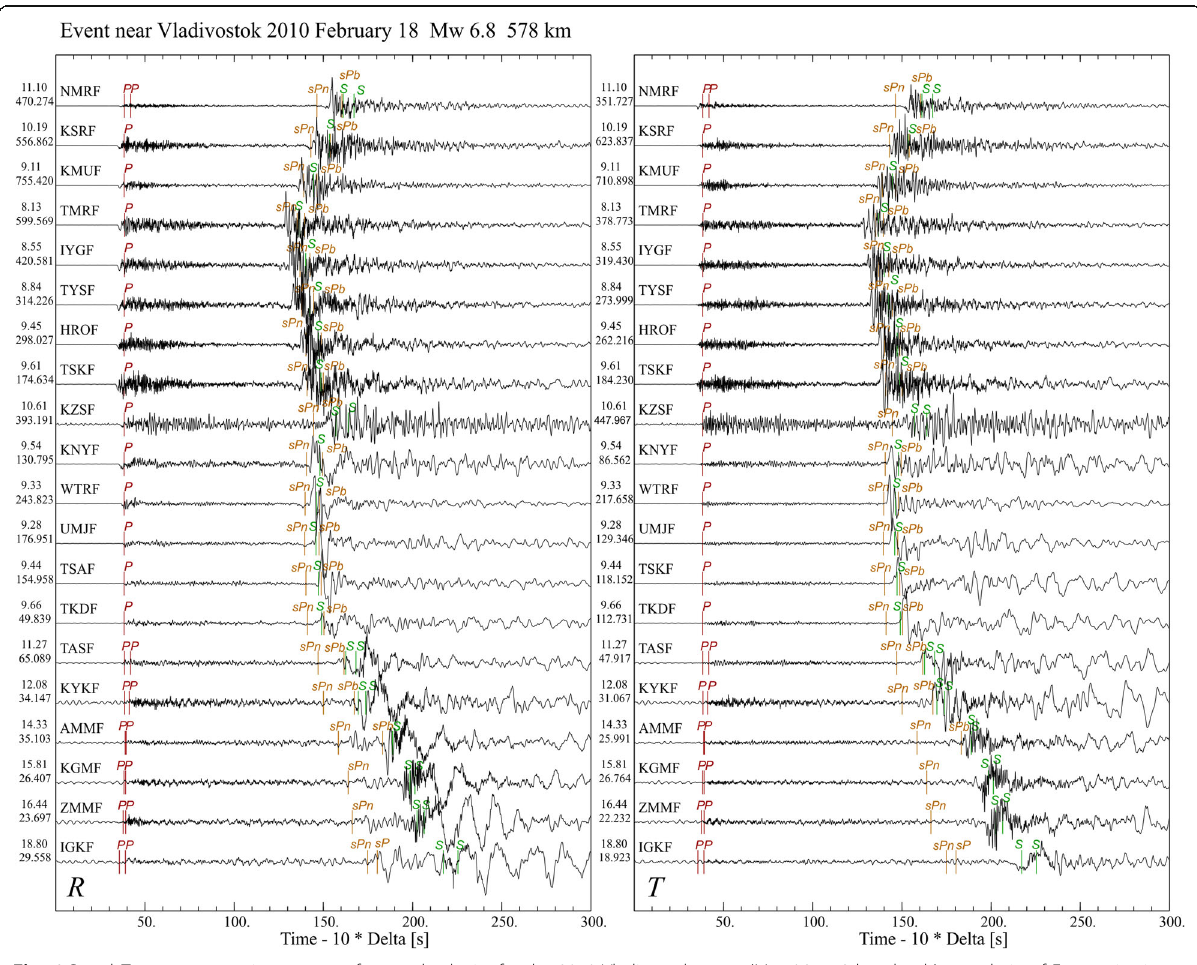
Fig. 6 R and T component seismograms of ground velocity for the 2010 Vladivostok event (Mw 6.8, 578 km depth) at a chain of F-net seismic stations along the Japanese islands, shown with solid symbols in Fig. 5. For each station, the epicentral distance is indicated in degrees, with the maximum amplitude in μ m/s shown below in smaller type. The travel times of the major phases for the ak135 model are indicated on each trace. Traces are normalized by the maximum three-component energy in the time